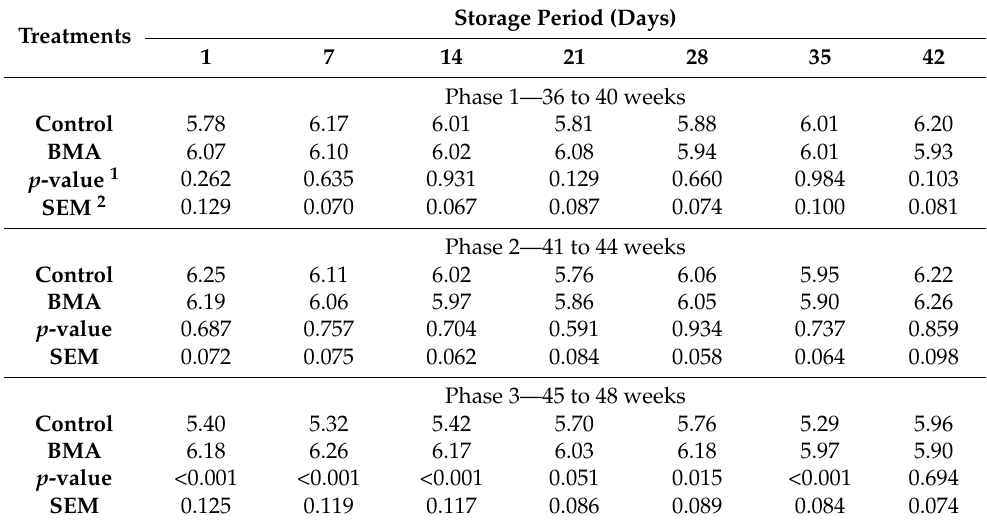
Table 8. Shell weight of eggs from laying hens fed with β -mannanase depending on storage time.